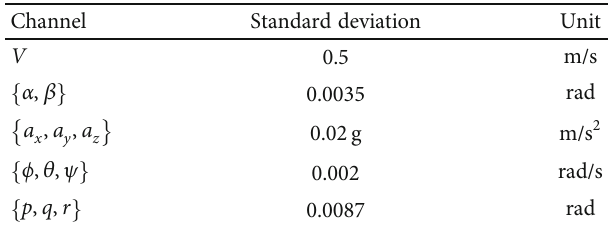
Table 2: Measurement noise con fi guration.